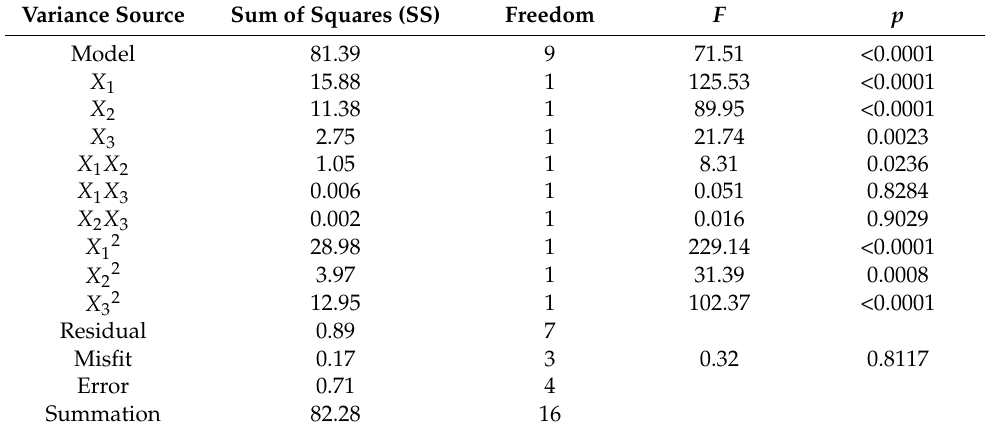
Table 4. ANOVA of seeding pass